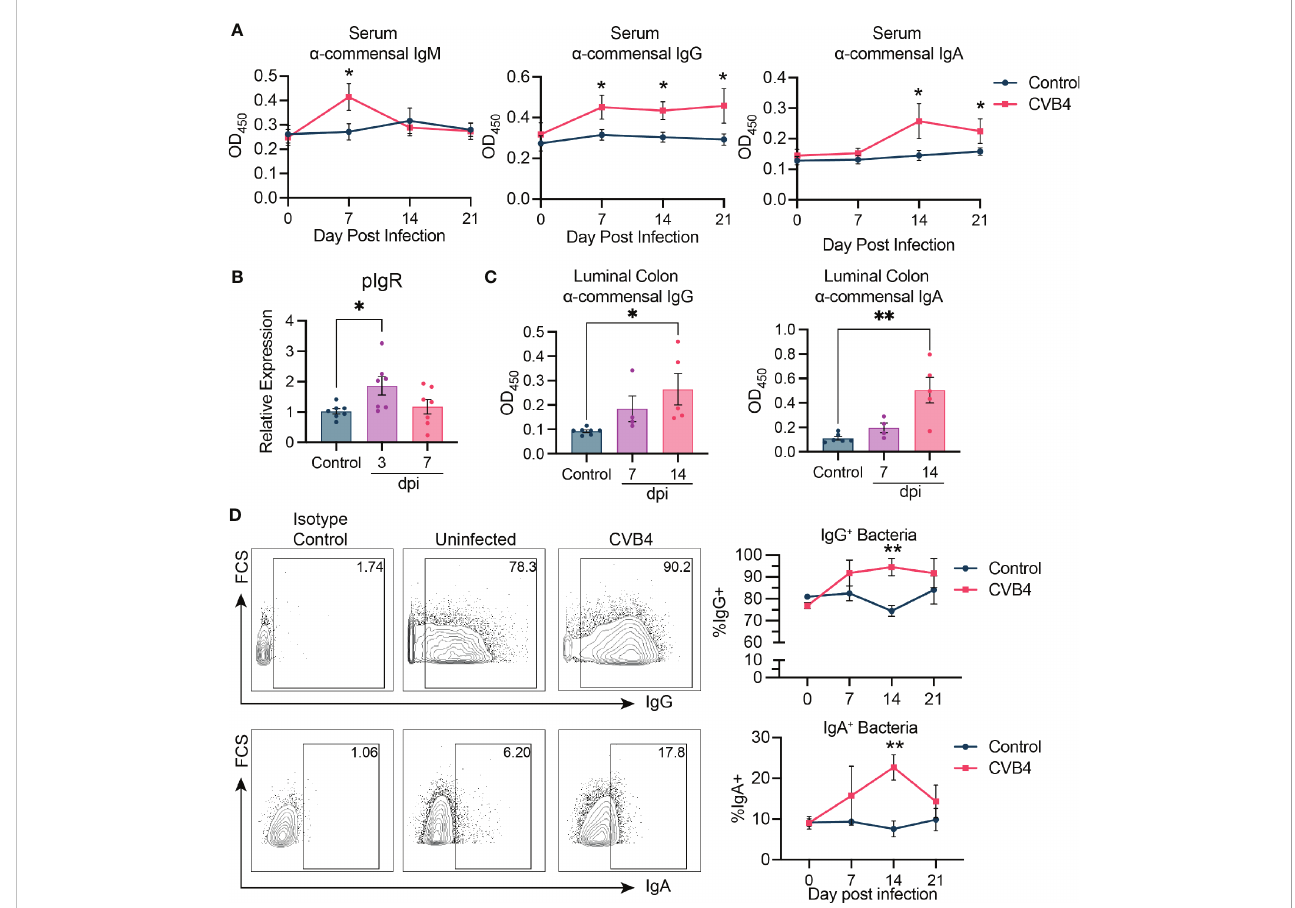
FIGURE 4 CVB4 modi fi es host responses to commensal bacteria (A) Abundance of bacterial antigen-speci fi c IgM, IgG, or IgA in the serum as measured by ELISA (n = 5-6 mice per group). Each sample was run in duplicate and averaged. (B) Relative expression of polymeric Ig receptor in the small intestine as determined by RT-qPCR. (C) Colonic luminal IgA and IgG reactivity to bacterial antigen as measured by ELISA. (D) Flow cytometry of bacteria from the feces of infected mice indicating proportion of microbes coated with either IgG (top) or IgA (bottom) antibodies. Representative fl ow plots showing gating of IgG and IgA bound microbes (left), and quanti fi cation on the right (n = 4 mice per group). Results are expressed as the mean ± SEM. P values in A and D are calculated by Two-Way ANOVA with Sida ́ k's multiple comparisons test while those in B and C were calculated via Welch's ANOVA